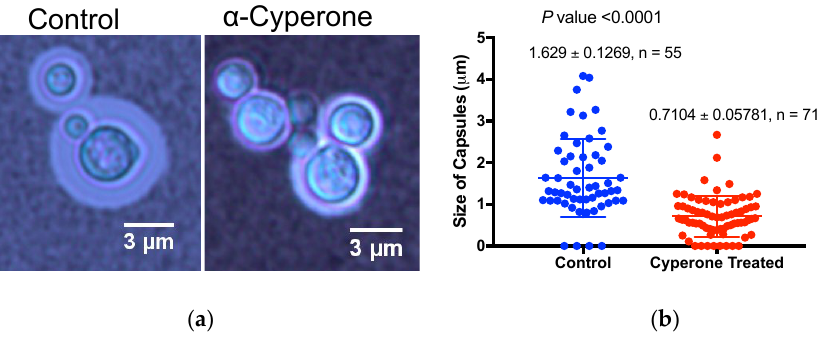
Figure 4. α -Cyperone inhibits the capsules in Cryp. neoformans . ( a ) Representative images of control (+ solvent) and α -Cyperone (16 µ g/mL, sub MIC) exposed Cryp. neoformans grown in Dulbecco’s Modified Eagle’s Medium (DMEM) for 48 h at 37 ◦ C. Capsules were visualized by India ink staining and examined under a microscope (Leica). ( b ) The size of capsules (in µ m diameter) in control and α -Cyperone treated samples were determined using ImageJ software. Statistical analysis of the data was performed using a two-tailed t -test with Welch’s correction (GraphPad). p -value < 0.0001.